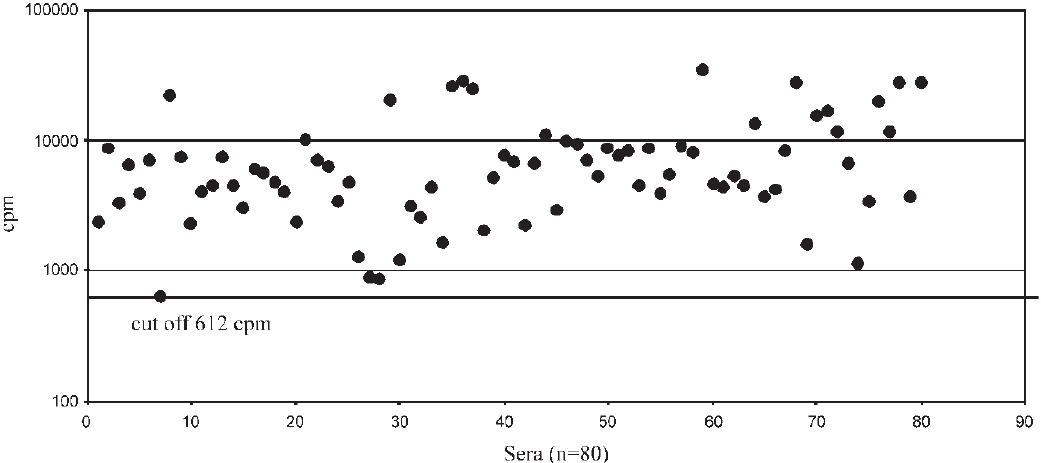
FIGURE 2 Reactivity of BCKADC-E2 positive sera with the human BCKADC-E2 by radoimmunoprecipitation